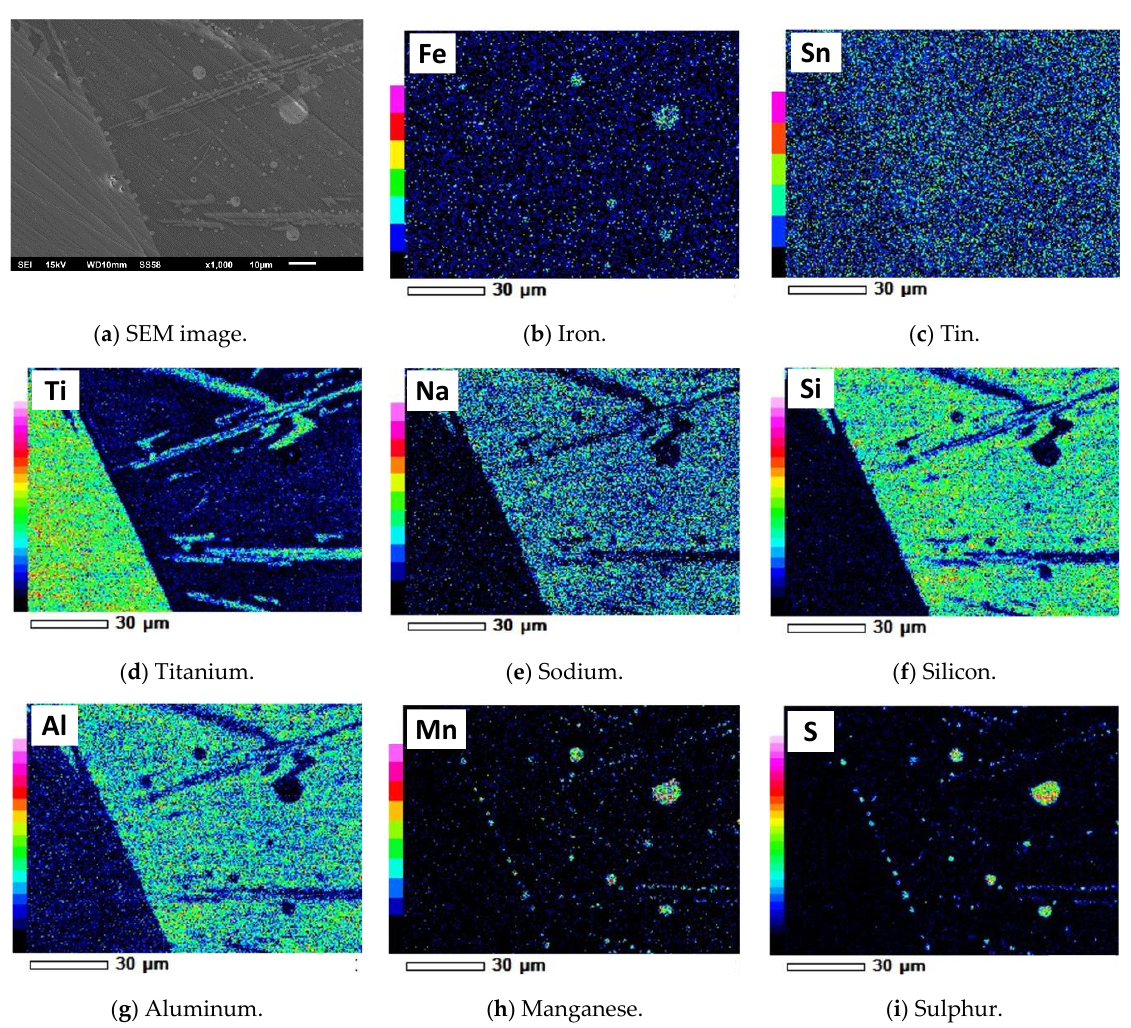
Figure 13. SEM-EDS elemental mapping of slag from the carbothermic reduction of the ilmenite concentrate at 60% Na 2 CO 3 addition, initial temperature of 1300 ◦ C, final temperatures of 1500 ◦ C, and heating rate of 6.6 C/min (pattern G).